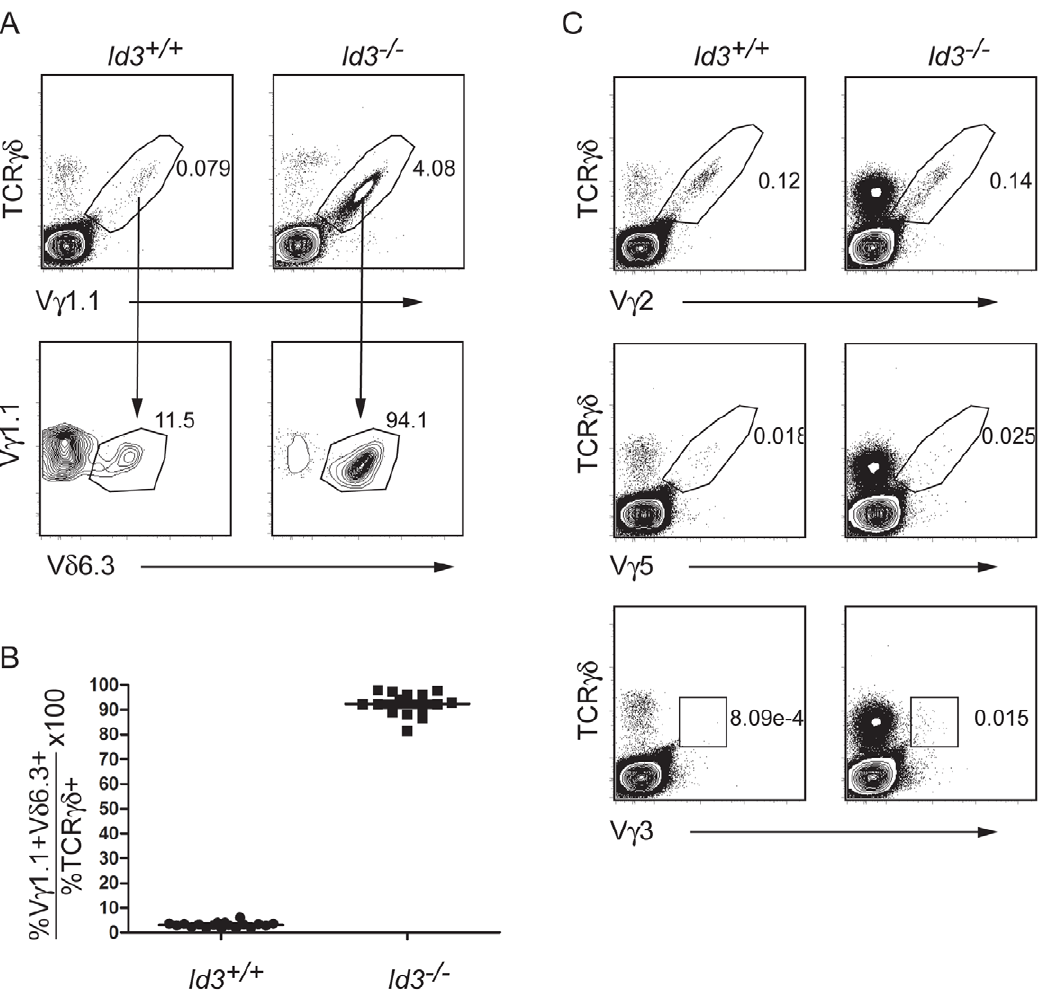
Figure 4. Id3 2 / 2 cd T cells are highly enriched for cells with a V c 1.1/V d 6.3 TCR. A) FACS analysis of thymocytes for TCR cd and V c 1.1 (top panel). The frequency of TCR cd + V c 1.1 + cells is shown. TCR cd + V c 1.1 + cells were analyzed for expression of V d 6.3 (bottom panel). The frequency of V c 6.3 + cells in the TCR cd + V c 1.1 + population is shown. B) Frequency of V c 1.1 + V d 6.3 + cells among TCR cd + cells in Id3 + / + and Id3 2 / 2 mice. Data were calculated by dividing the frequency of V c 1.1 + V d 6.3 + cells by the frequency of TCR cd + cells ( 6 100). Each dot represents the frequency from on